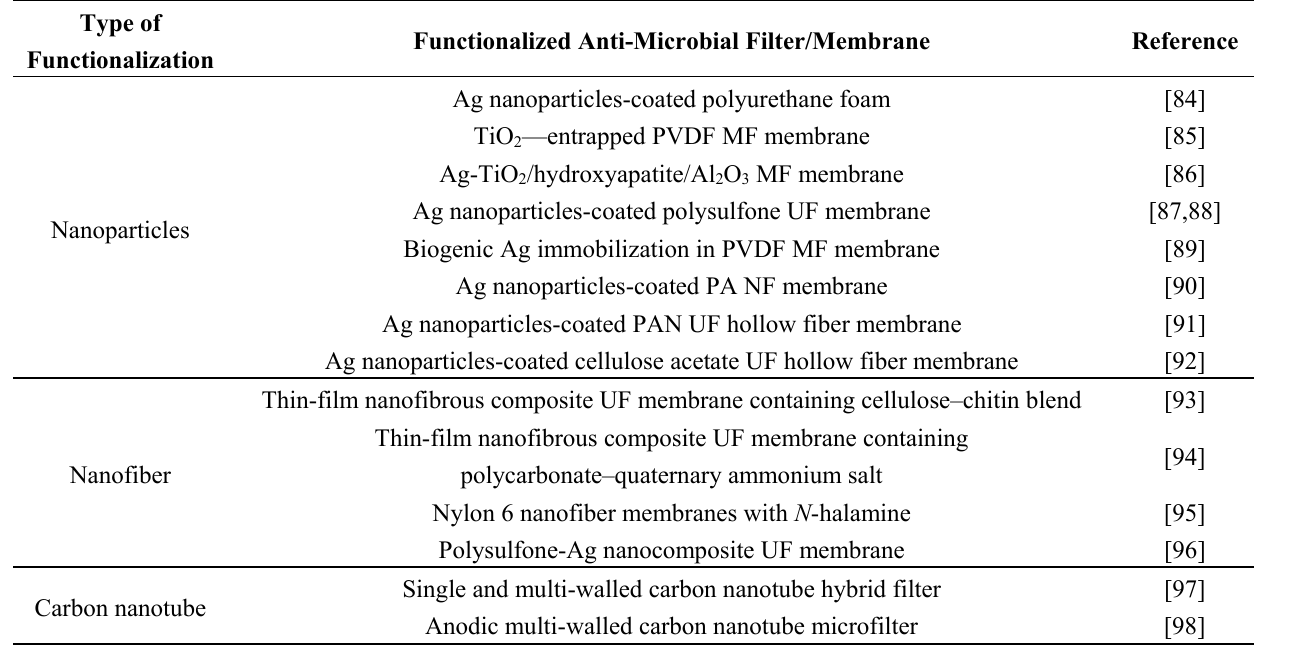
Table 5. Different types of functionalized anti-microbial filters/membranes. Type